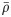
Non-local effects in the RNA crosstalk scenario derived for the CLASH interactome.(a) Mean Pearson coefficient ρ¯ quantifying the degree of locality of crosstalk patterns as a function of the mean miRNA transcription rate β¯ for different degrees of TH. (b) Behaviour of ρ¯ as a function of β¯ in different BH scenarios for a given TH scenario (CVtr = 0.4). Results are obtained in the high-BH scenario by averaging over 100 independent realizations of transcription rates for each degree of TH. In each case, the standard error of the mean is equal to or smaller than the size of the markers.